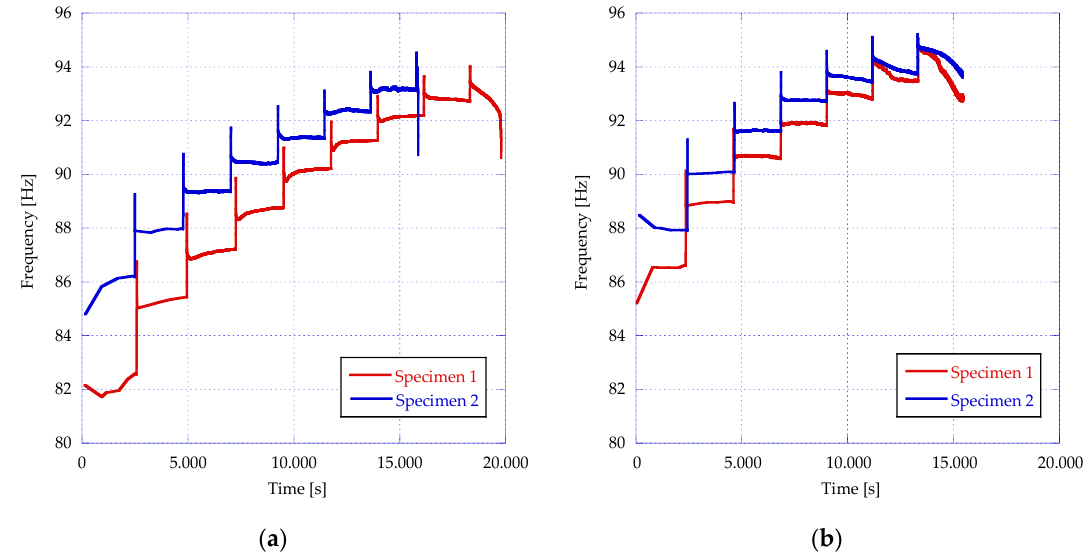
Figure 5. Evolution of the resonance frequency in each step for the LLC ( a ) and SLC ( b ) mix.